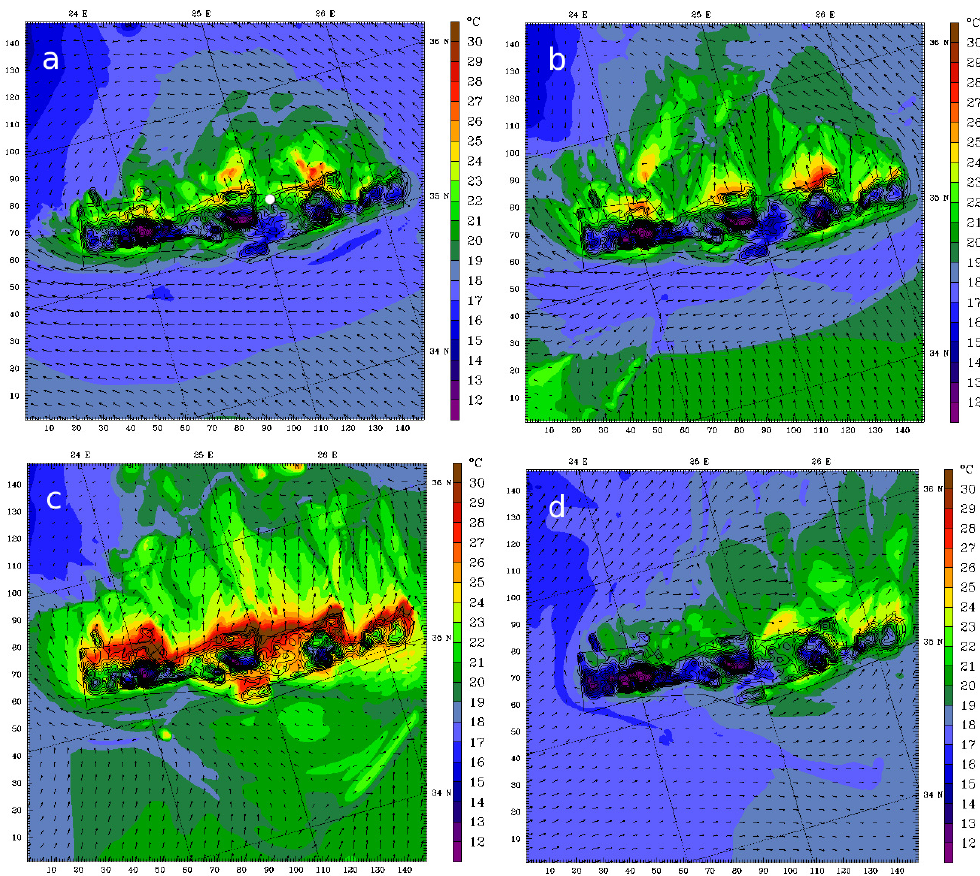
Fig. 7. Simulated 2m temperature (color contour) and surface wind field (arrows) at domain 3 at (a) 00:00, (b) 04:00, (c) 09:00 and (d) 17:00 UTC on 23 March 2008. The white point in (a) indicates the location of Heraklion.